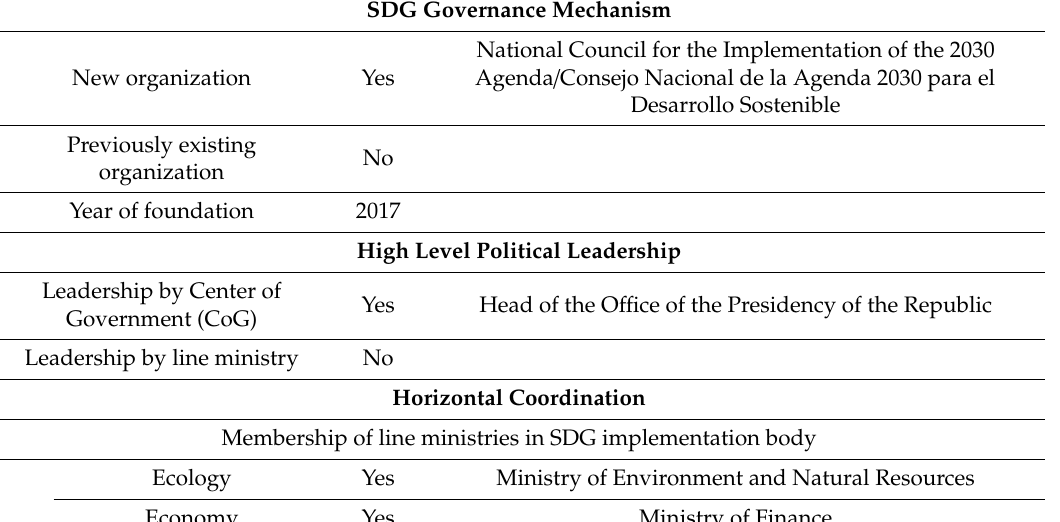
Table A3. The Mexican SDG-Implementation